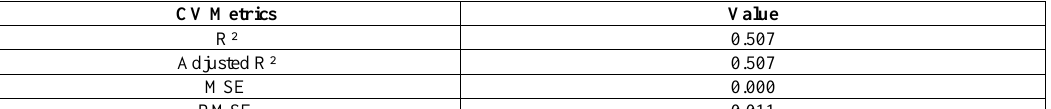
Table 2. The output result of cross-validation.